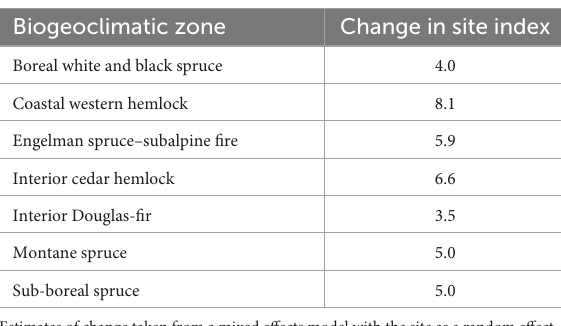
TABLE 2 Difference between site indices (ecosystem-based site index minus inventory-based site index) by biogeoclimatic zone in ground plots.